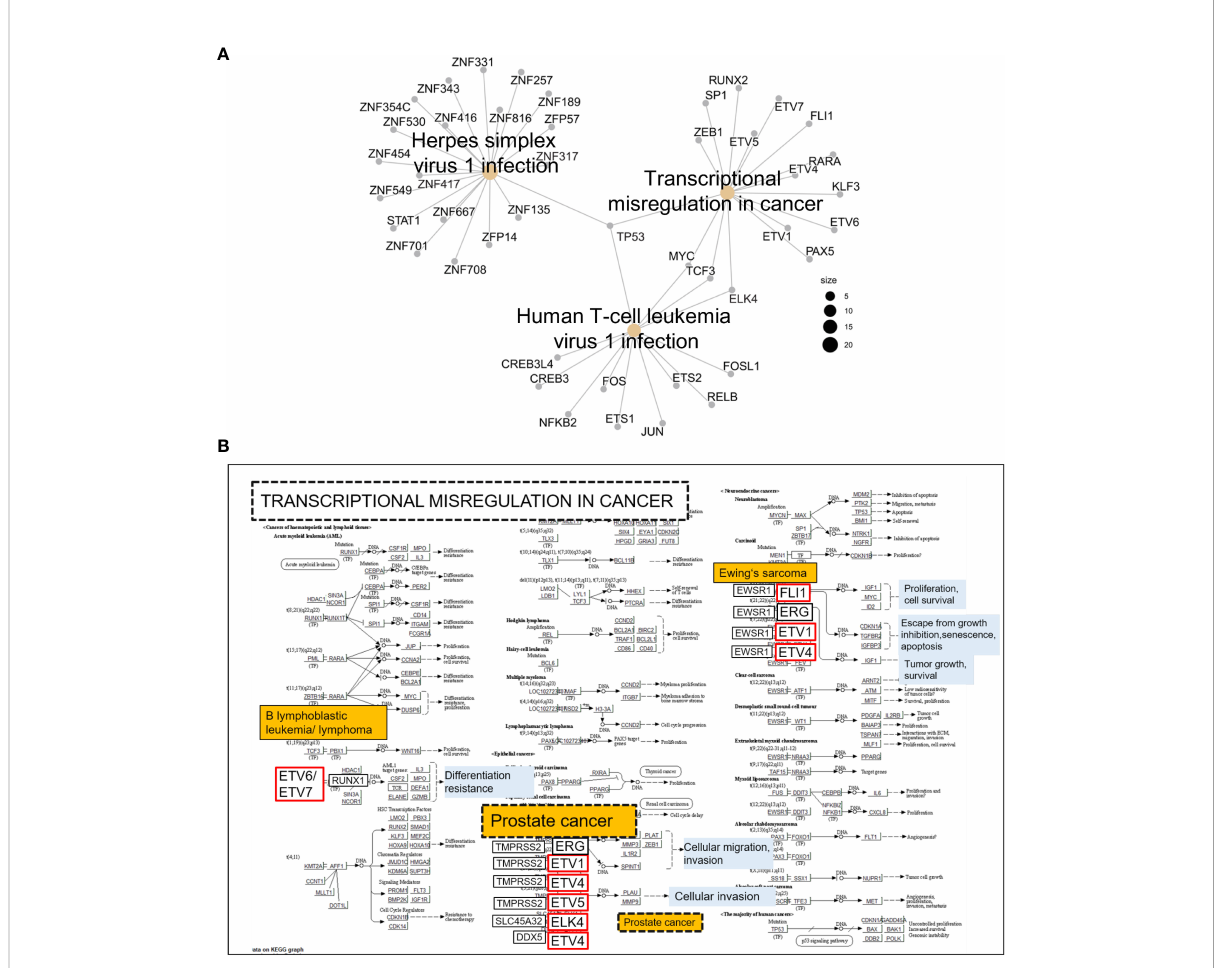
FIGURE 5 Kyoto Encyclopedia of Genes and Genomes (KEGG) pathway analysis of transcription factors (TFs) with predicted binding sites in IRAK1 -DMR. TFs with binding scores ≥ 300 were considered (JASPAR-2022). (A) Cnet plot showing top three enriched KEGG pathways among TFs with predicted strong binding sites in IRAK1 -DMR. (B) The enriched KEGG pathway ‘ Transcriptional misregulation in cancer ’ is shown together with implicated TFs exhibiting predicted binding sites in IRAK1 -DMR (red